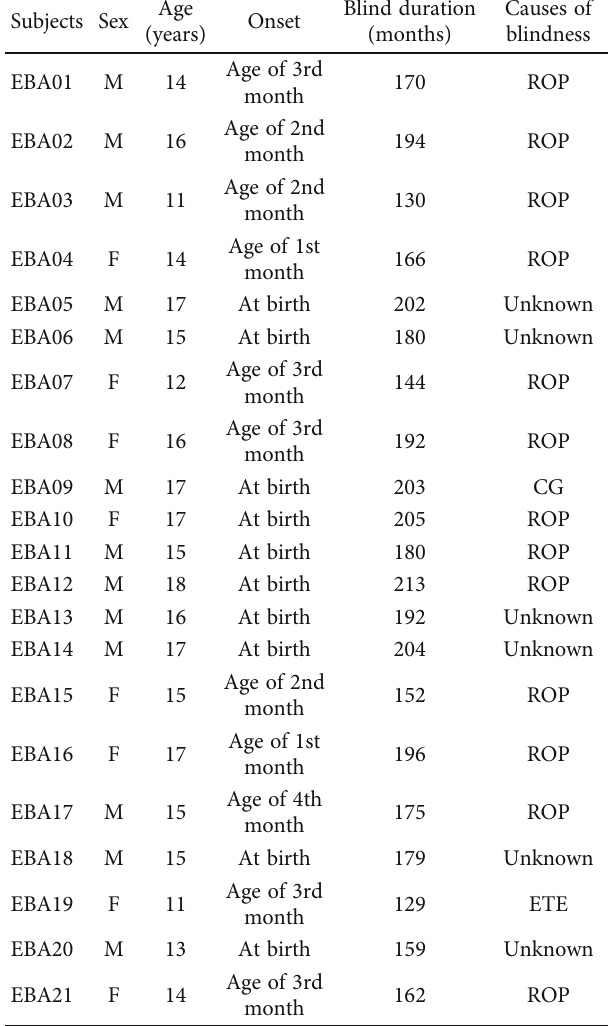
Table 1: Clinical characteristics of blind